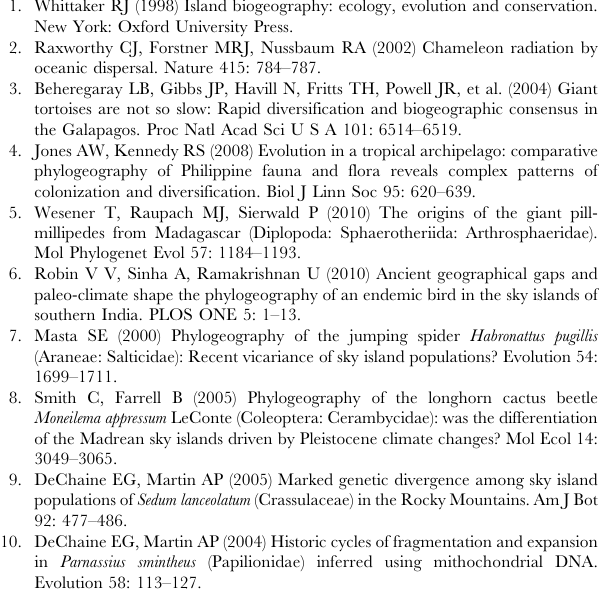
Table S2 The three, best-fit models determined in IMa2 for tests of migration versus isolation between the paraphyletic populations Koolyanobbing and Helena Aurora. Results are based on mtDNA